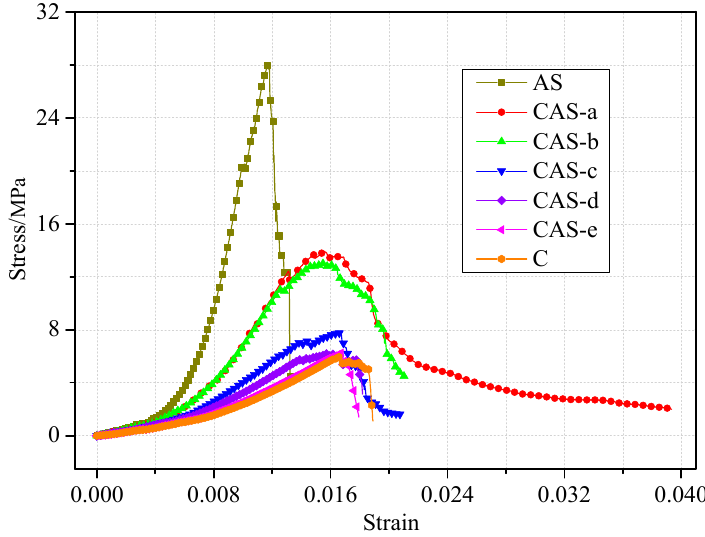
Figure 5. Average strain–stress curves for different specimens.